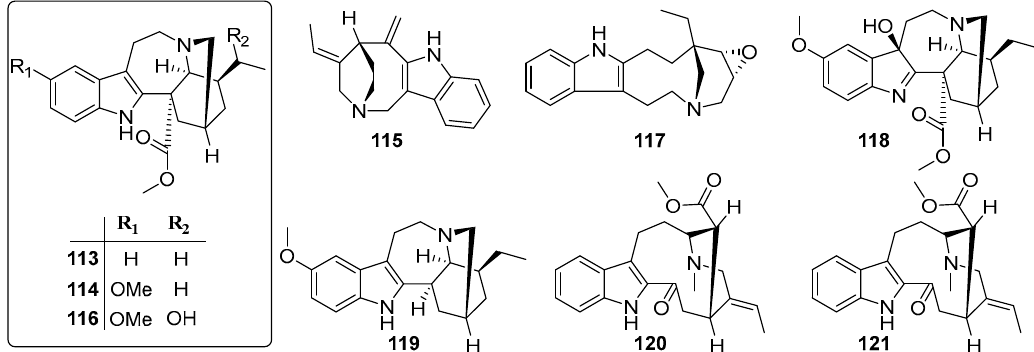
Figure 5. Alkaloids from the Trachelospermum plants.